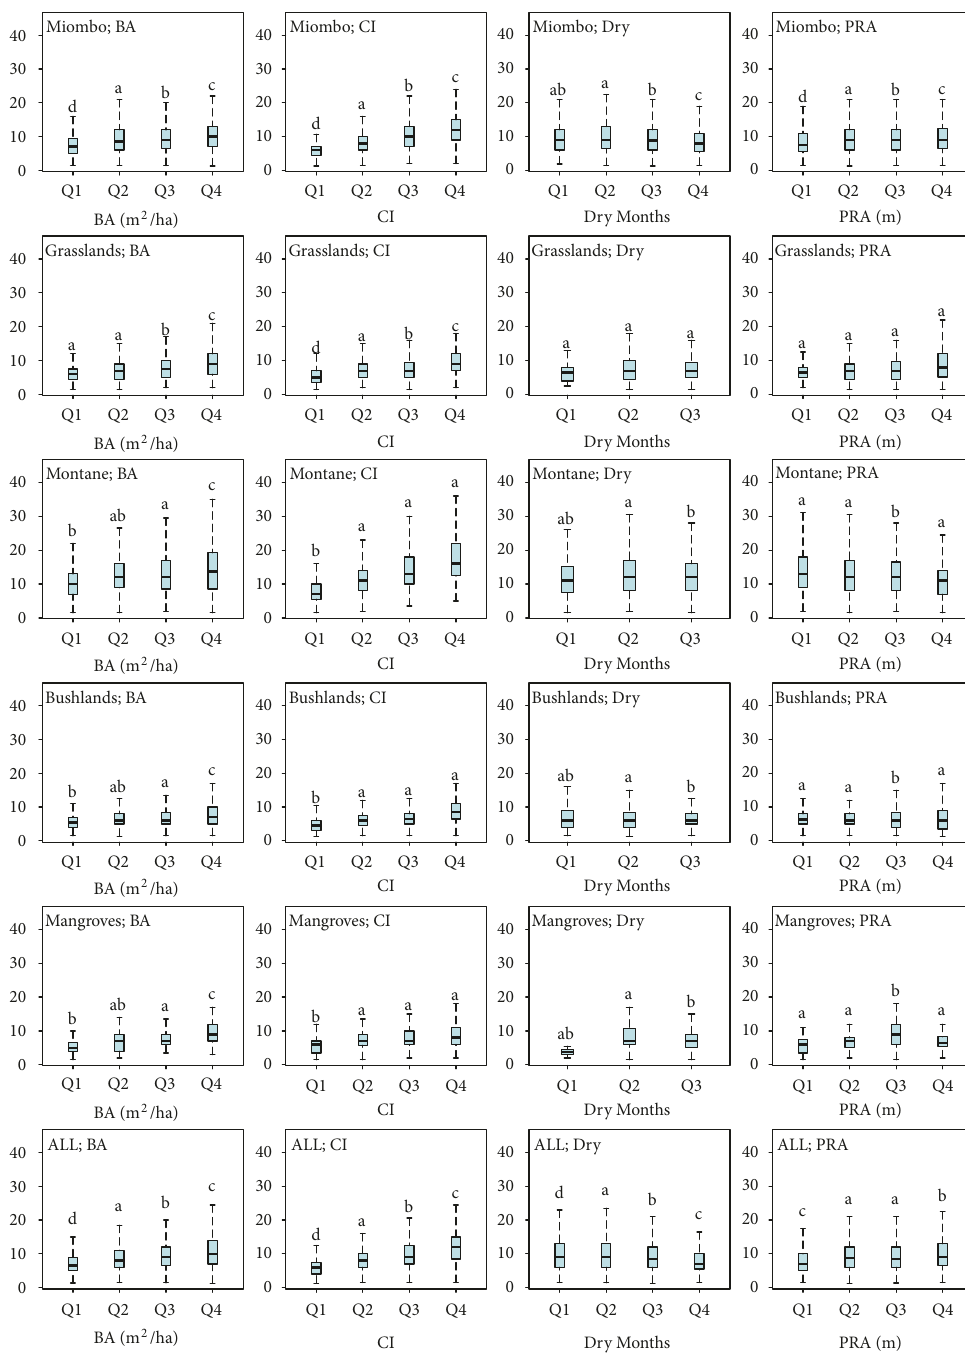
Figure 4: The relationship of total tree height ( H ) with forest stand ( BA , CI ) and climatic variables (number of dry month and precipitation). Different letters indicate significant differences among groups. Q1, Q2, Q3, and Q4 are